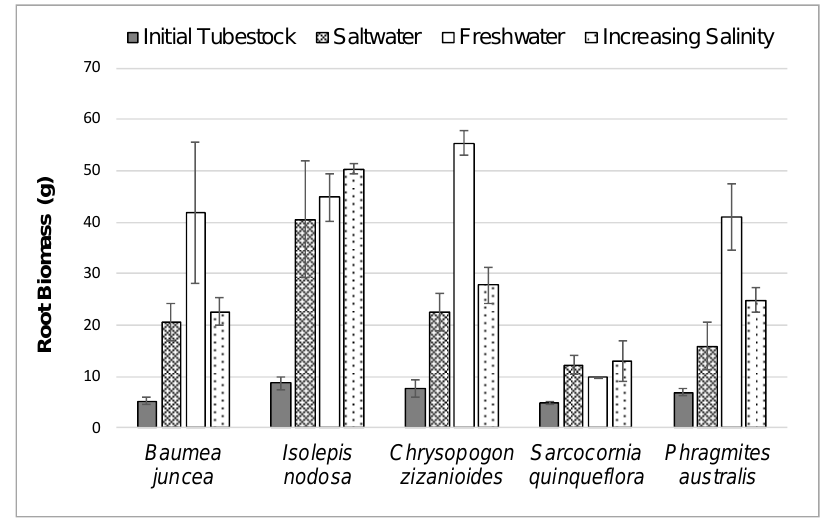
Figure 5. Average Initial and Final Root Biomass for Each Species in Each Water Treatment. Root growth rate was calculated as a percentage change from the initial tubestock root mass at the start of the study until the plants were harvested at the end of the study. The percentage change in root mass for each species is shown in brackets in Table 3. Table 3. Initial Tubestock Root Mass and Final Plant Root Mass for Each Species in Each Water Treatment (Percentage Change in Root Mass Shown in Brackets).